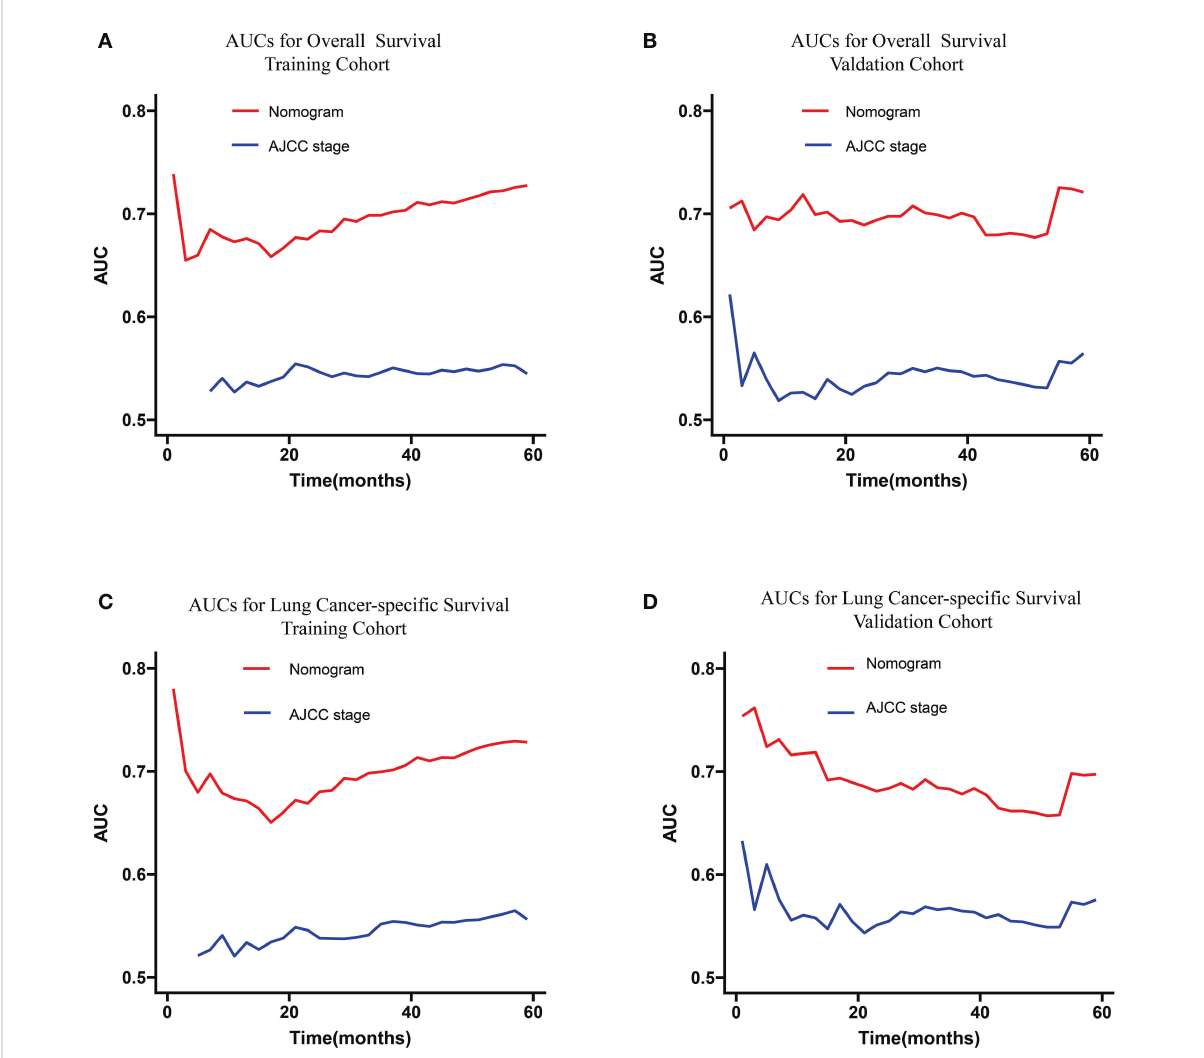
FIGURE 6 Continuous AUCs of the nomogram (red) and 8th edition AJCC TNM staging system (blue) in the training (A, C) and validation cohorts (B, D) throughout the period of 1 – 60 months. AUC, area under the curve; AJCC, American Joint Committee on